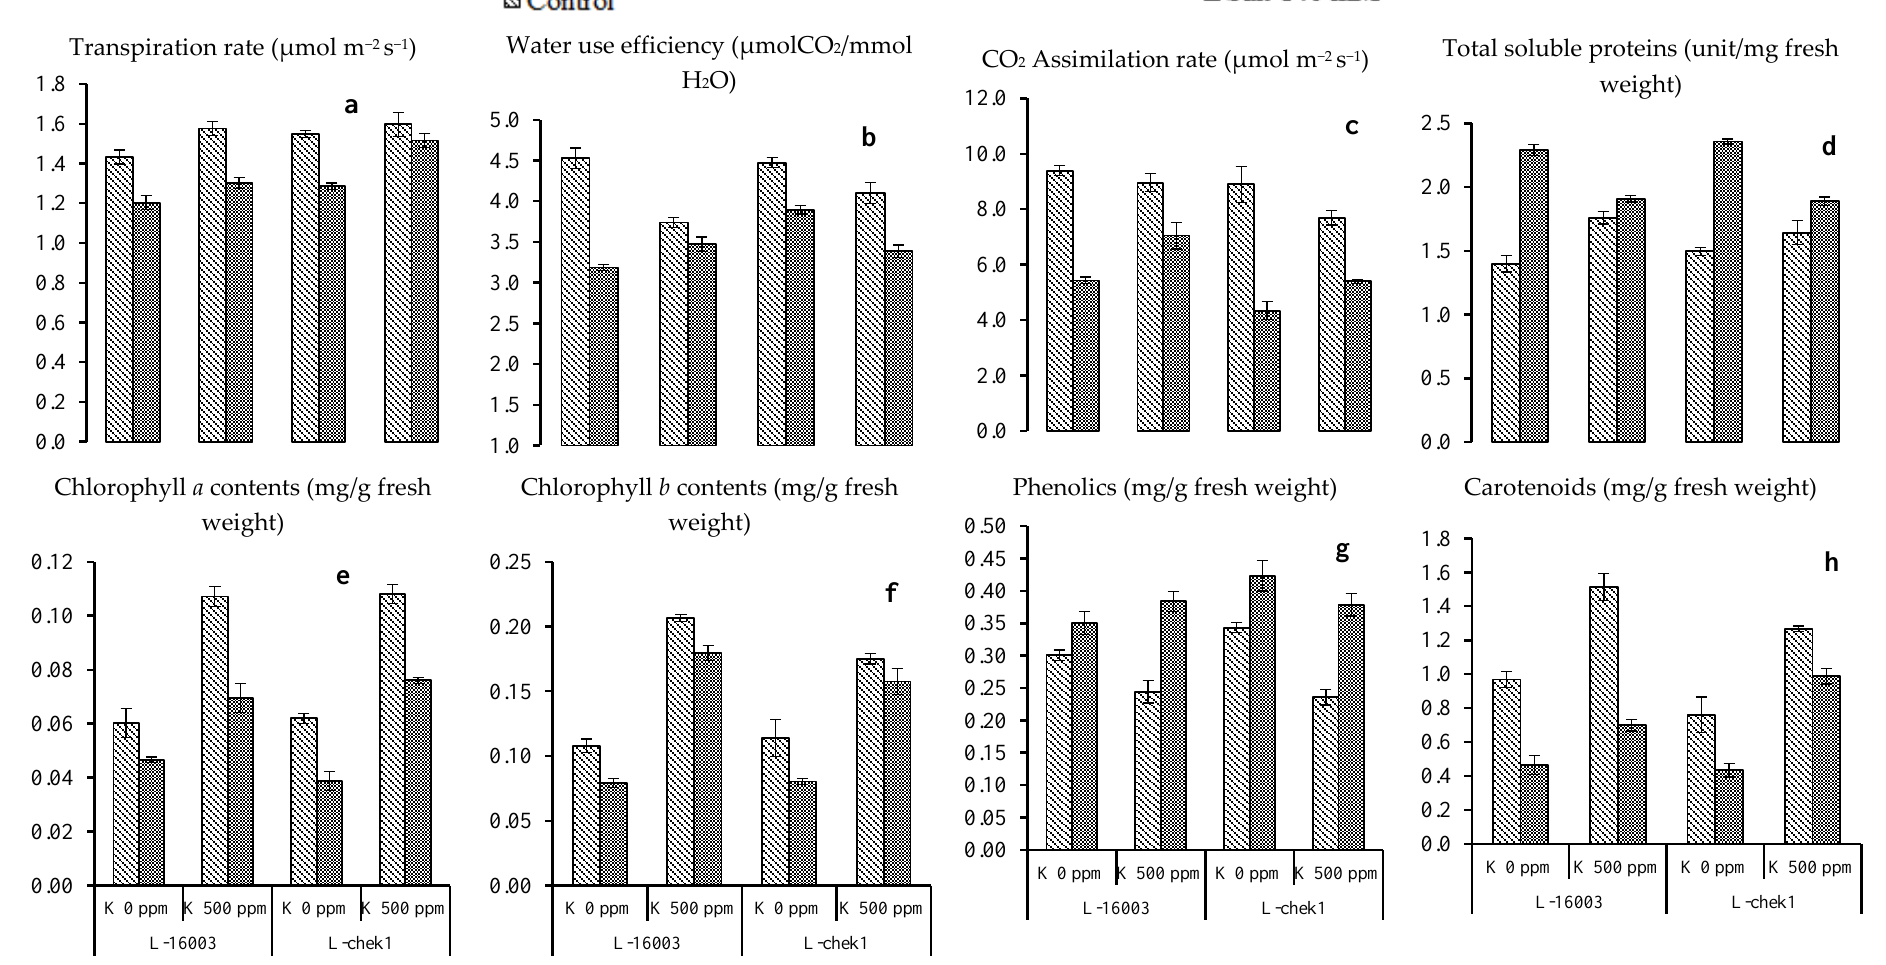
Figure 2. Impact of foliar applied potassium on transpiration rate on the ( a ) water use efficiency, ( b ) CO 2 assimilation rate, ( c ) total soluble proteins, ( d ) chlorophyll a, ( e ) chlorophyll b, ( f ) phenolics, ( g ) and carotenoids ( h ) of sunflower hybrids grown under a salinity stress environment.